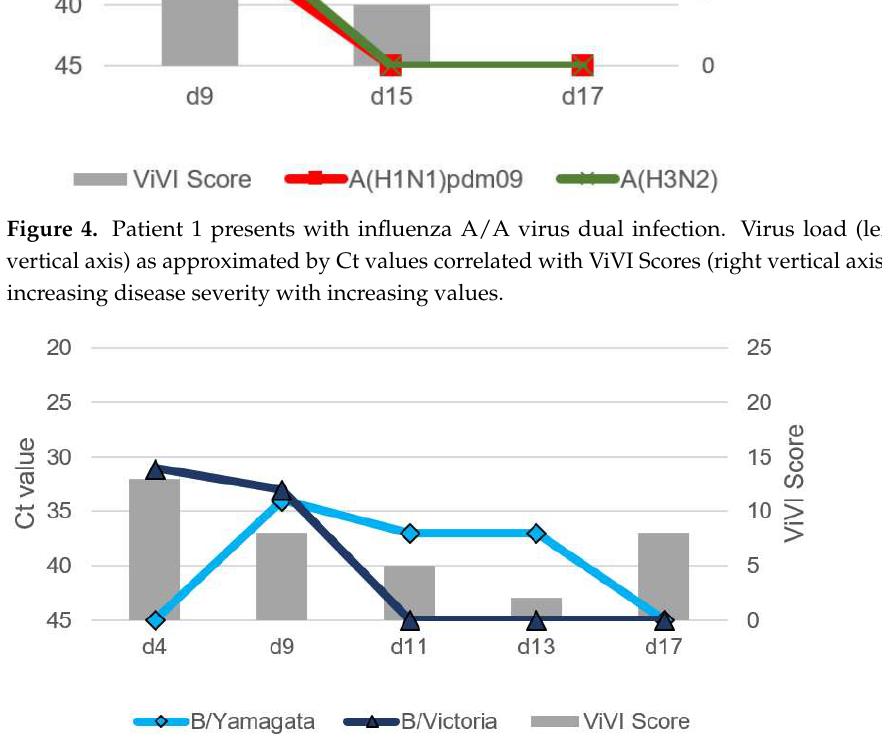
Figure 6. Patient 3 presenting with influenza A/B virus dual infection. Virus load (left inverted ver- tical axis) as approximated by Ct values correlated with ViVI Scores (right vertical axis) reflecting increasing disease severity with increasing values.